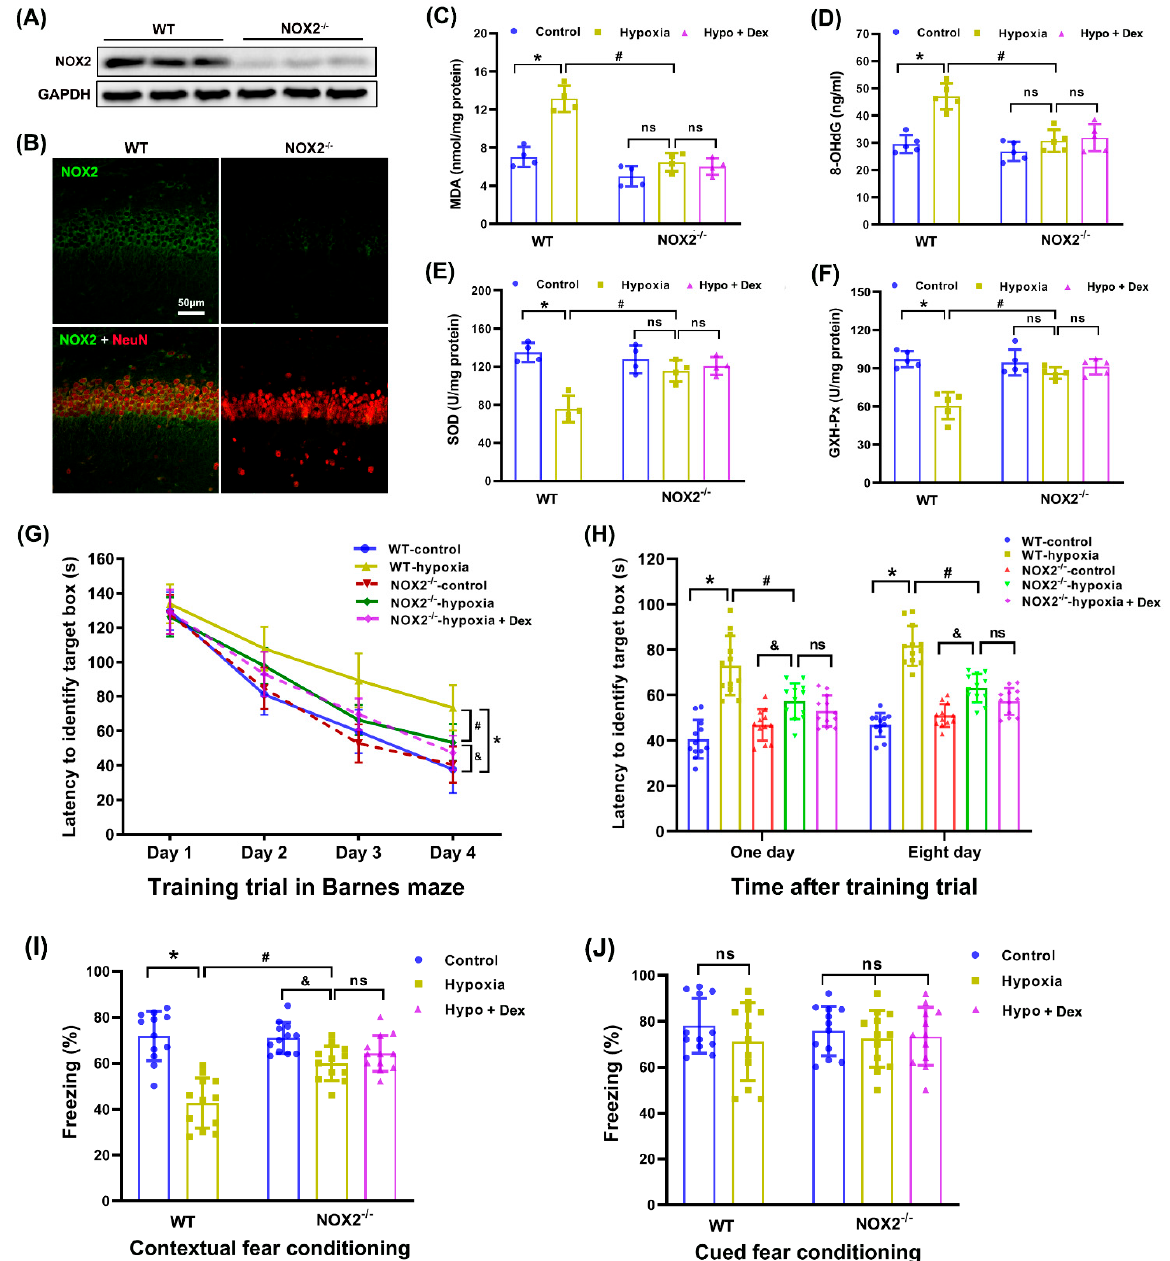
Figure 7. Modulation of Dex-induced neuroprotection in neonatal mice by NOX2 depletion. ( A , B ) Representative images of the genetic identification of NOX2 − / − neonatal mice via Western blotting and immunofluorescence assays in the hippocampus. ( C ) MDA levels were assessed using the TBA colorimetric method. ( D ) DNA 8 − OHdG levels were assessed using an 8 − OHdG ELISA kit. ( E ) SOD activity was assessed using the WST − 1 method. ( F ) GSH − Px activity was assessed using the UV colorimetric assay. ( G ) Performance with the Barnes maze test in the training sessions. ( H ) Performance with the Barnes maze test in the memory phase. ( I ) Contextual fear conditioning test. ( J ) Cued fear conditioning test. Results are expressed as mean ± SD ( n = 4 in each group for panel A and B; n = 4–5 in each group for panel C to F; n = 12 in each group for Barnes maze and fear conditioning test data). Each animal data point in the bar graph is also presented. * p < 0.05, # p < 0.05, & p < 0.05 for the comparison. ns, not